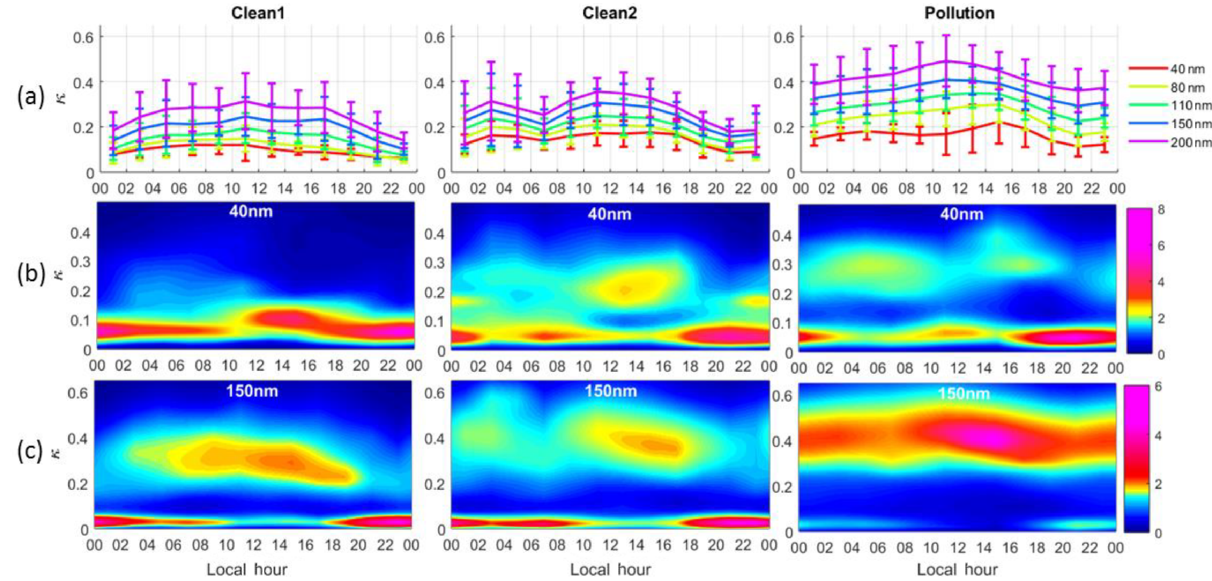
Figure 5. Diurnal variations in (a) mean κ ( κ mean ) for different mobility diameters, (b) κ -PDF for particles with D p equal to 40nm, and (c) κ -PDF for particles with D p equal to 150nm during the Clean1, Clean2, and Pollution periods.